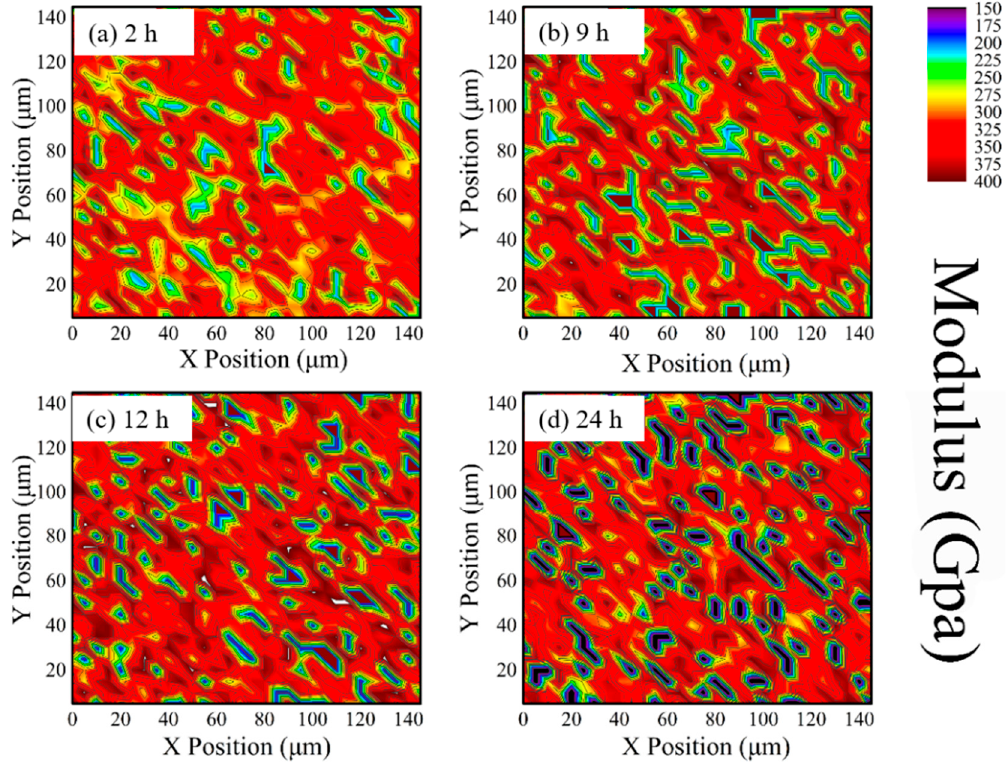
Figure 4. Plane projections of Young’s modulus of 8YSZ with annealing time ( a ) 2 h, ( b ) 9 h, ( c ) 12 h, ( d ) 24 h. The right color scale indicates Young’s modulus variation.